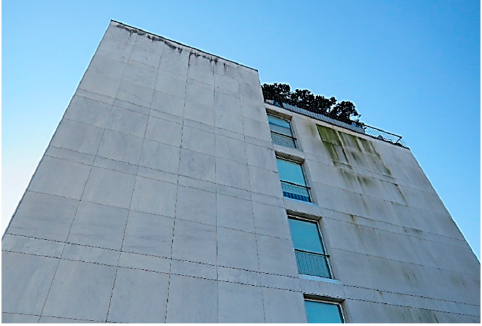
Figure 1. Partial view of the stone cladding applied on the north façade of the building.